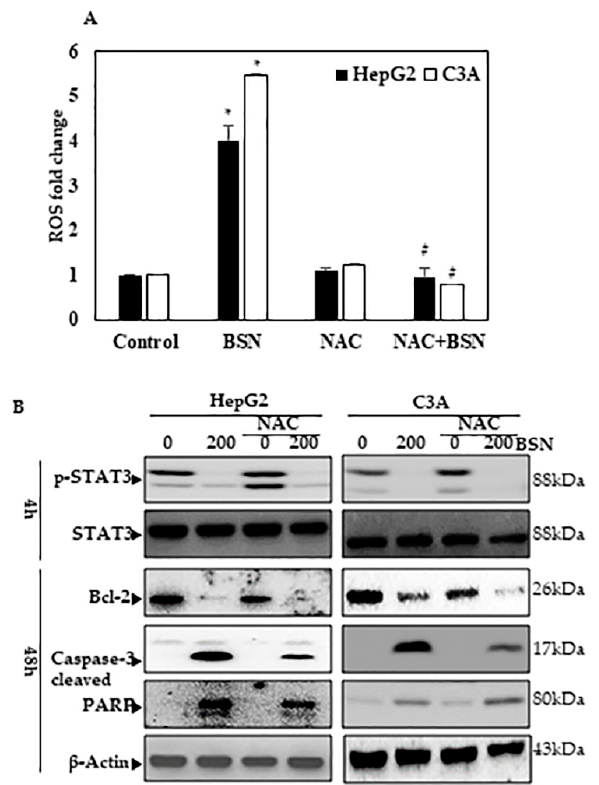
Figure 3. In hepatic carcinoma cells, BSN induced apoptosis through ROS. ( A ) The ROS levels in Hepg2 and C3A cells were measured after pre-treatment with NAC (N-acetylcysteine) (1 mM) for 1 h and then treated with BSN (0–200 µ mol for 2 h). ( B ) NAC (1 mM) for 1 h, followed by BSN (0 and 200 µ mol) for 4 h, and then STAT3, Bcl-2, caspase-3, and PARP activation for 48 h. The p -STAT3, Bcl-2, caspase-3, and PARP expressions were monitored by Western blotting. Tukey’s post hoc test was used in this study to analyze the data. p < 0.05 was considered significant. Graph Pad prism was used. Experiments were conducted in triplicate. Data are presented as the mean ± SD. Furthermore, * p < 0.05 vs. control. # p < 0.05 vs BSN treatment.